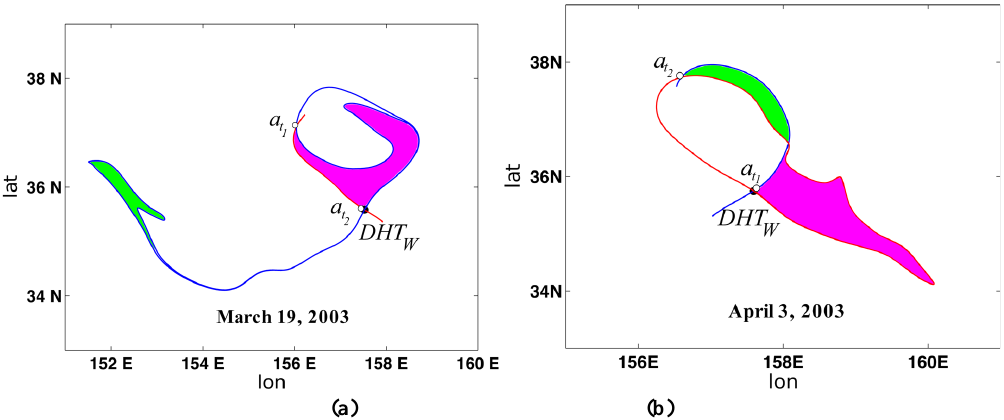
Fig. 19. Turnstile lobes across the western eddy at dates 19 March and 3 April 2003. The intersection trajectories a t at both dates showing their clockwise circulation around the eddy. The magenta area evolves from the inside to the outside while the green area does from the outside to the